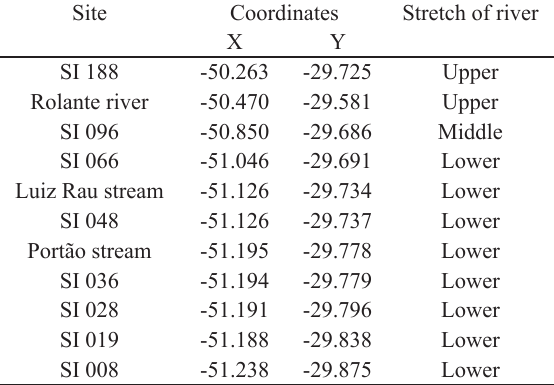
Location of the sediment sampling